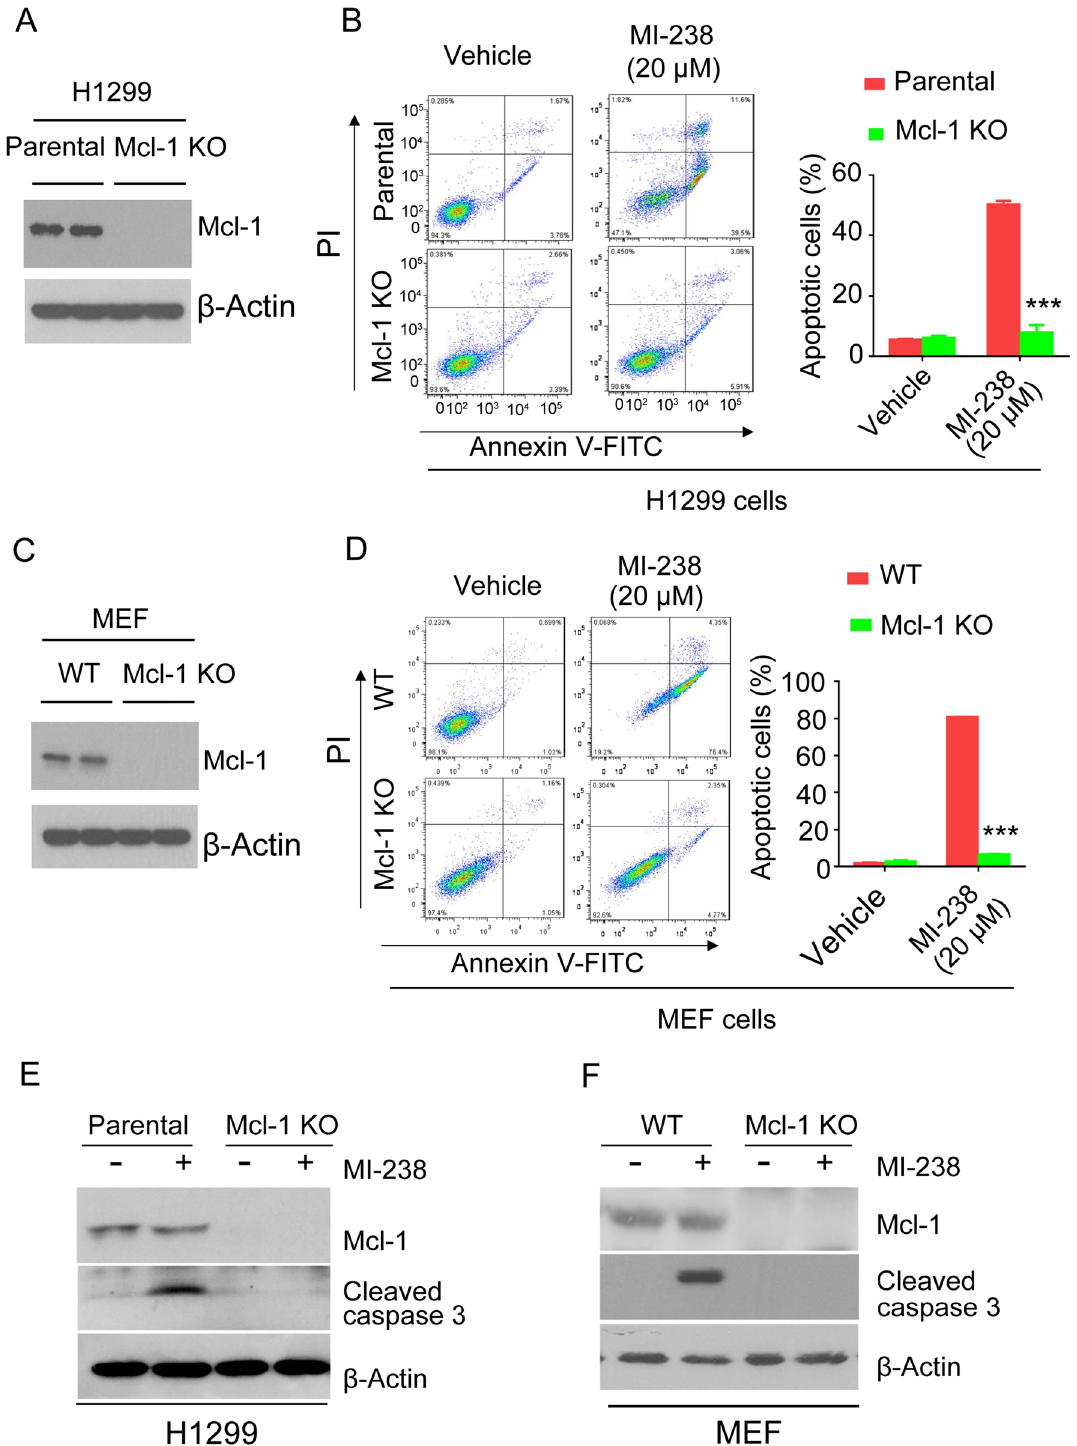
Fig. 2 MI-238 selectively induces apoptosis in Mcl-1 proficient cells. A Western blotting analysis of indicated protein expressions in cell lysate derived from H1299 parental or Mcl-1 knockout (KO) cells. B H1299 parental or Mcl-1 KO cells were treated with or without 20 μM MI-238 for 48 h, and the cell apoptosis were analyzed by annexin V staining. C Western blot analysis as above were performed in MEF wild-type (WT) or Mcl-1 KO cells. D Apoptosis analysis as above were performed in MEF wild-type (WT) or Mcl-1 KO cells. E , F Cell apoptosis were analyzed by caspase 3 cleavage in H1299 ( E ) or MEF ( F ). Data are represented as mean SD from three independent replicates, *** P < 0.001 by two-tailed ±